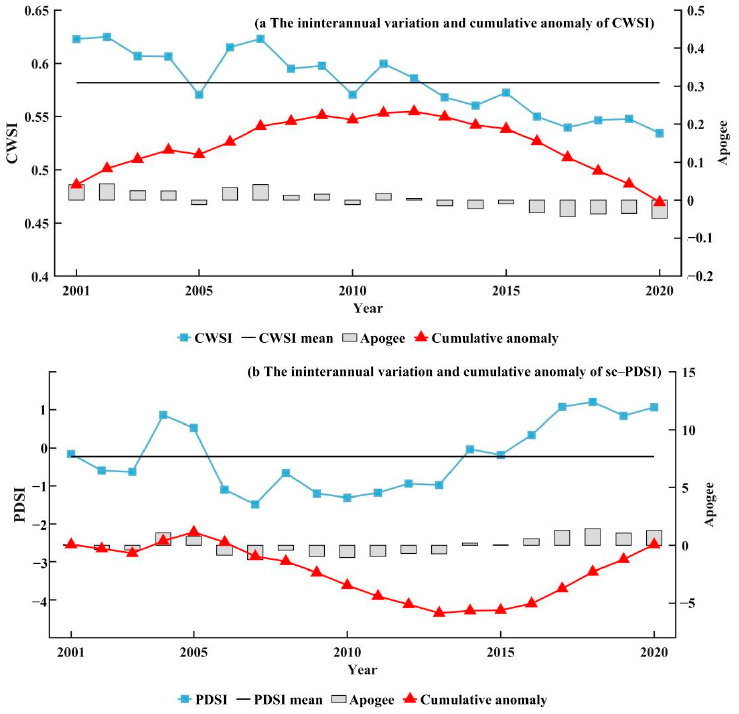
Figure 6. The interannual variation and cumulative anomaly of CWSI and